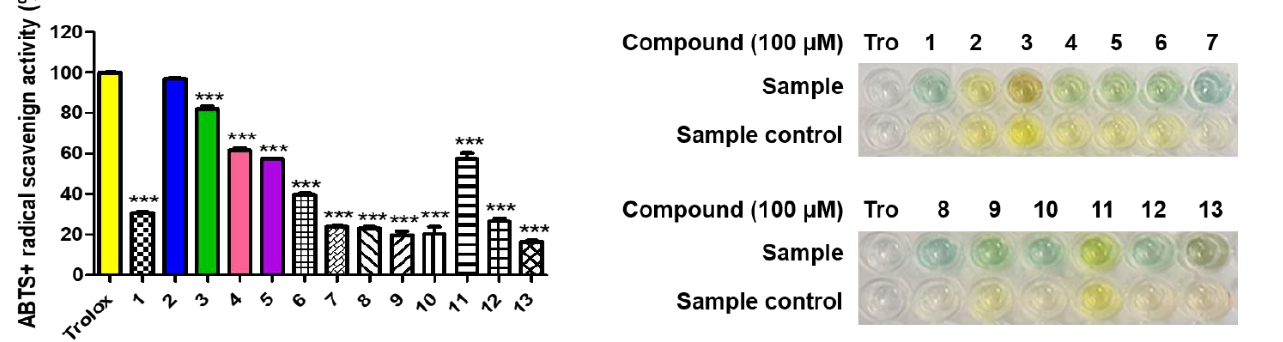
Figure 12. The ABTS free radical scavenging activities of ( Z )-BPTT analogs. The ABTS radical scavenging activity of ( Z )-BPTT analogs was investigated at a concentration of 100 µM after 2 min in the dark and trolox (Tro) was used as a positive control. DMSO was used as a solvent for ( Z )-BPTT analogs and trolox. Asterisks represent significant differences between trolox and ( Z )-BPTT analogs 1 – 13 and results represent the means ± standard errors of 3 different experiments. *** p < 0.001.